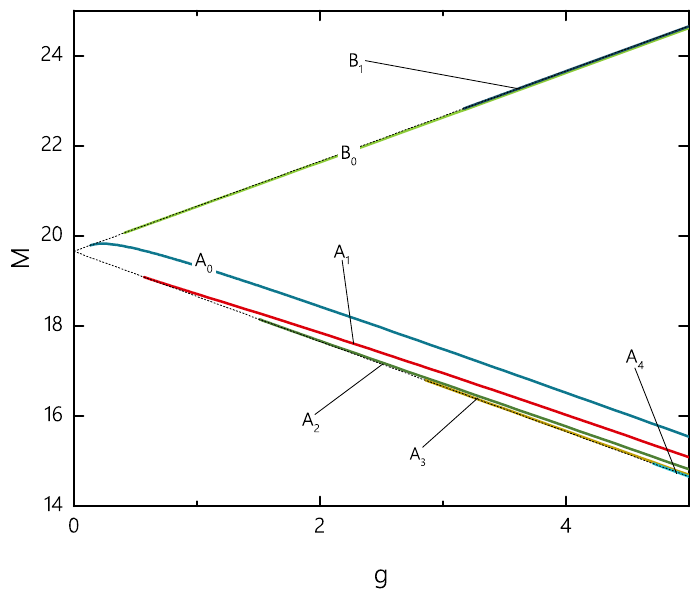
Figure 3 . The total energy (2.7) for changing the coupling constant g